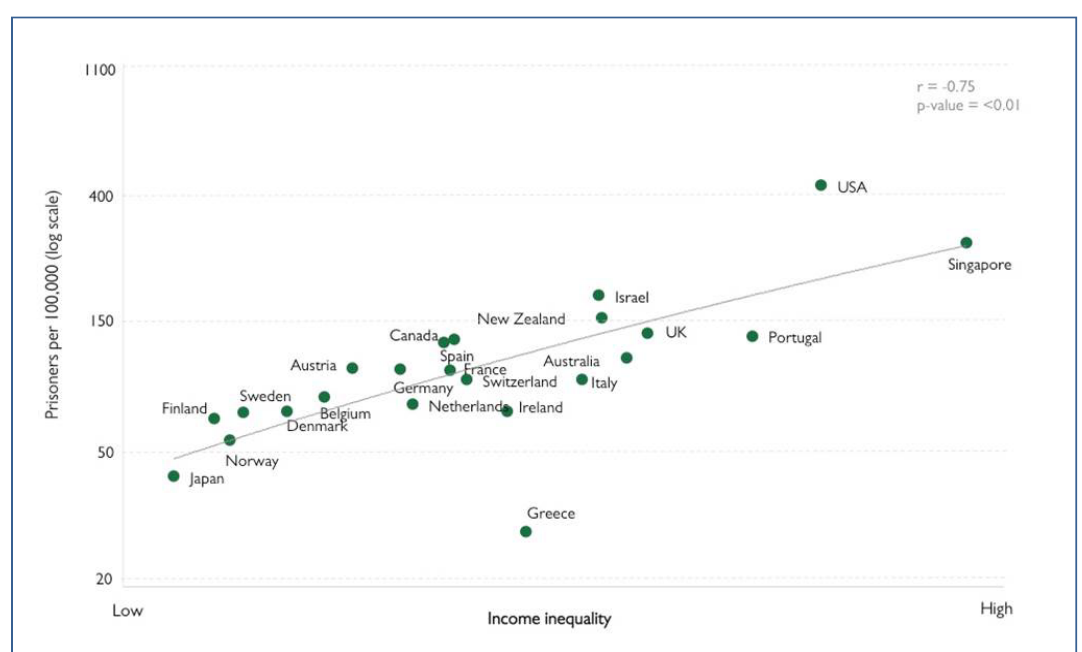
Figure 1: The relationship between income inequality and prison rates Source: The Equality Trust (2013); Wilkinson and Pickett